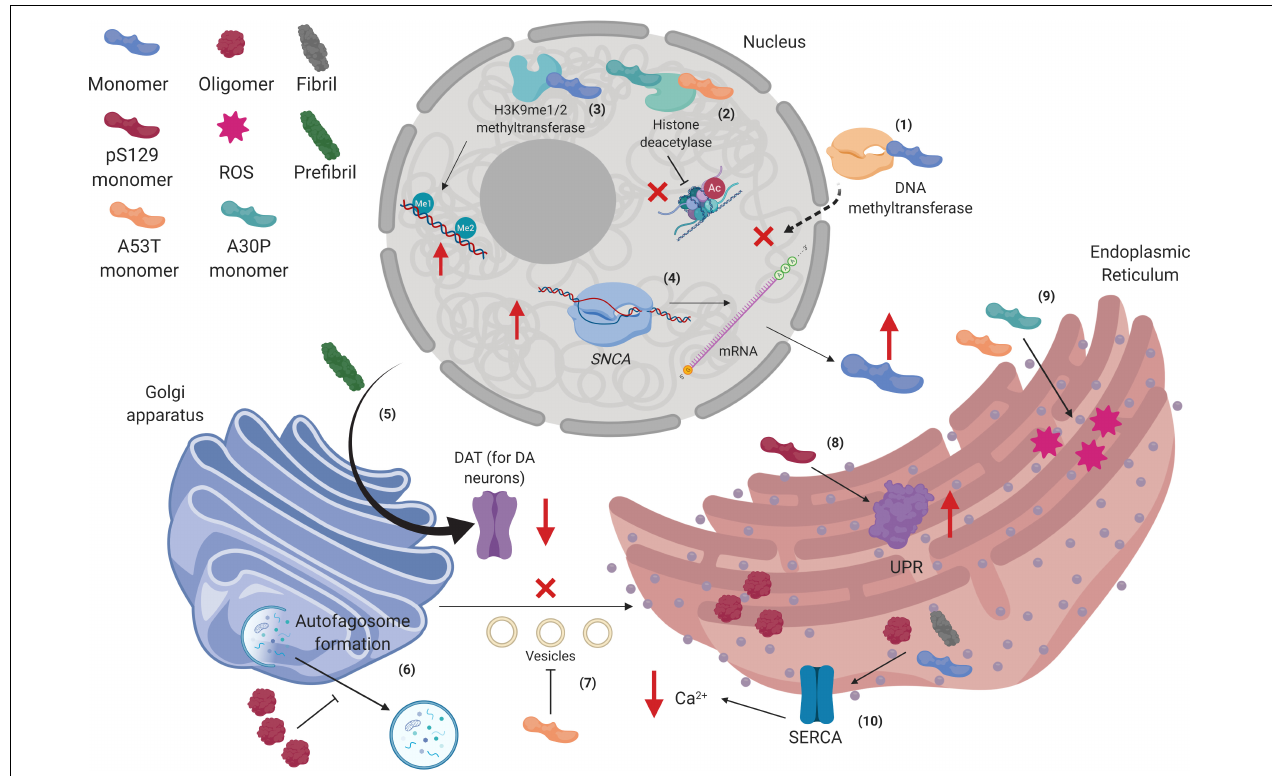
FIGURE 3 | Alpha-synuclein interactions in the nucleus, Golgi apparatus, and the endoplasmic reticulum. (1) Human wild type alpha-synuclein (hWT α -syn) can retain methyltransferases in the cytoplasm, thus altering DNA methylation of the SNCA gene. (2) hWT α -syn can also interact with H3K9me1/2 to increase mono- and dimethylation in the DNA. (3) p.A53T and p.A30P monomers bind to HDACS and inhibit histone deacetylation. (4) Decreased epigenetic regulation on the SNCA gene promotes its up-regulation, increasing α -syn transcription and further accumulation. (5) Prefibrillar α -syn can disrupt postraductional processing of dopamine transporter (DAT) in the Golgi apparatus (GA), diminishing its presence in the membrane. (6) α -syn oligomers impair autophagosome formation in the GA. (7) p.A53T monomers inhibit vesicles transport from endoplasmic reticulum (ER) to GA. (8) pS129- α -syn monomers increase unfolded protein response (UPR) activity in the ER. (9) p.A53T and p.A30P monomers increase levels of stress in the ER. (10) α -syn oligomers and fibrils affect SERCA complex in the ER, diminishing cytosolic levels of Ca 2 + . Created with